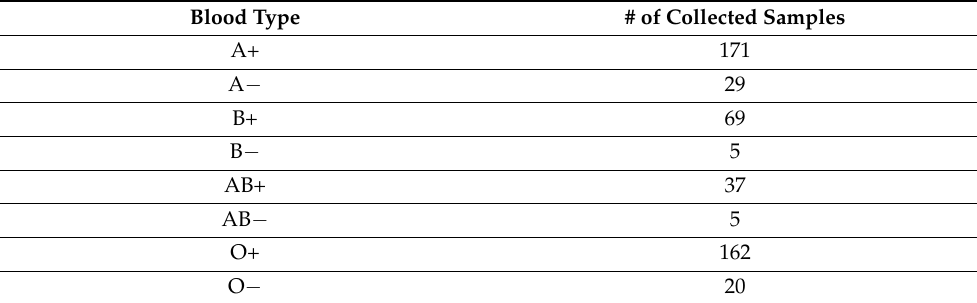
Table 3. Distribution of the collected blood